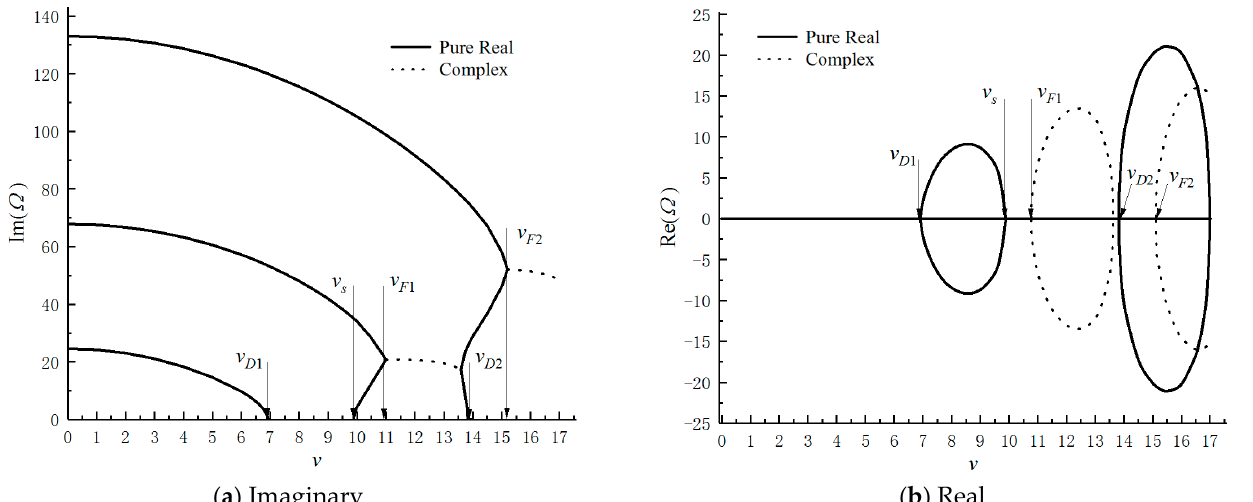
Figure 5. Curve of the imaginary part of the first three complex frequencies of CC beam changing with axial velocity. Table 4. Critical velocity of dimensionless axial motion of FGM beam with functionally graded materials under different boundary conditions.